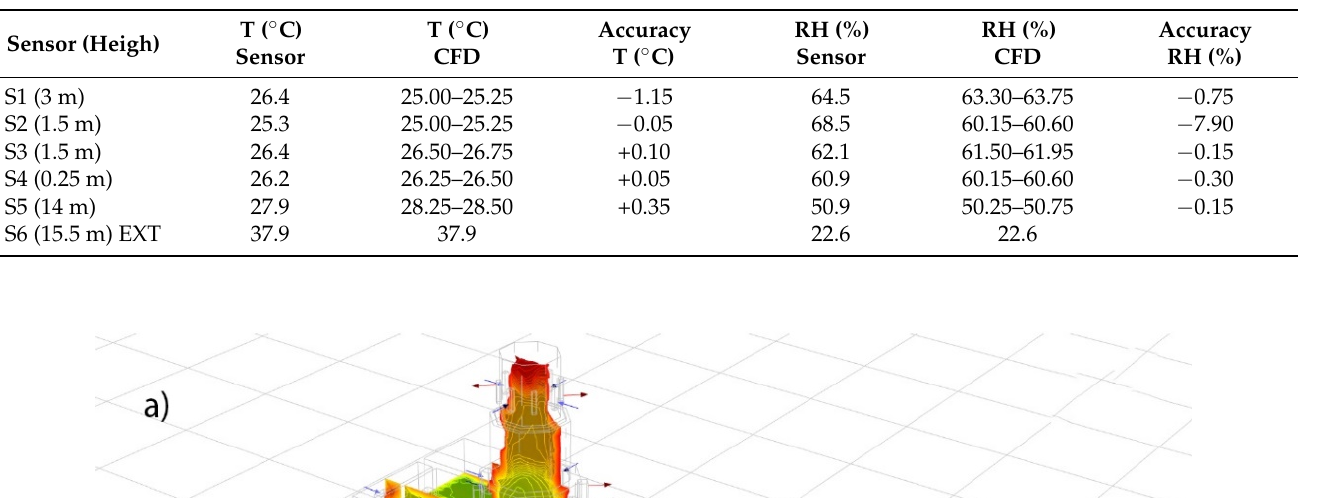
Table 11. Comparison of temperature and relative humidity in the case of summer.